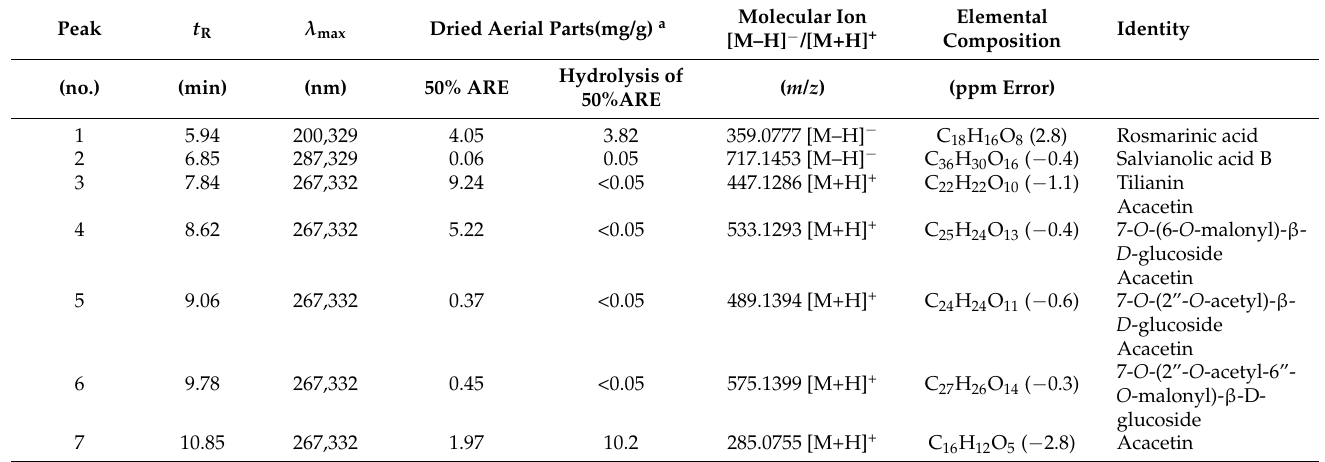
Table 2. Spectroscopic characteristics and contents (mg/g) of the seven investigated compounds from the aerial parts of A. rugosa